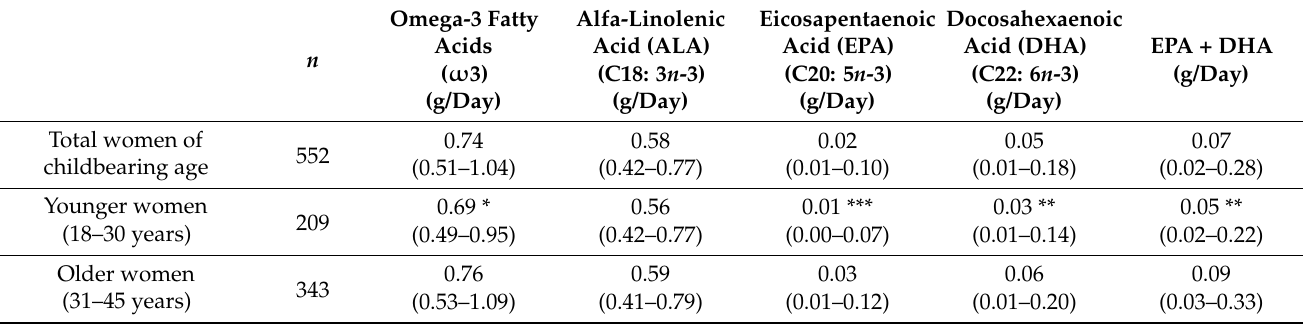
Table 2. Omega-3 fatty acid dietary intake among women of two childbearing age groups from the ANIBES Study.